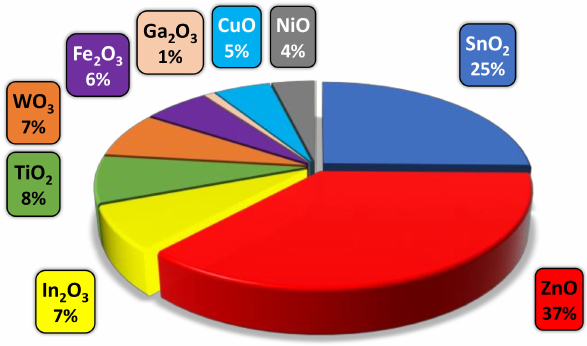
Figure 1. A survey of the most applicable gas sensitive MOXs reported in the literature (Web of Science database from 1998 to